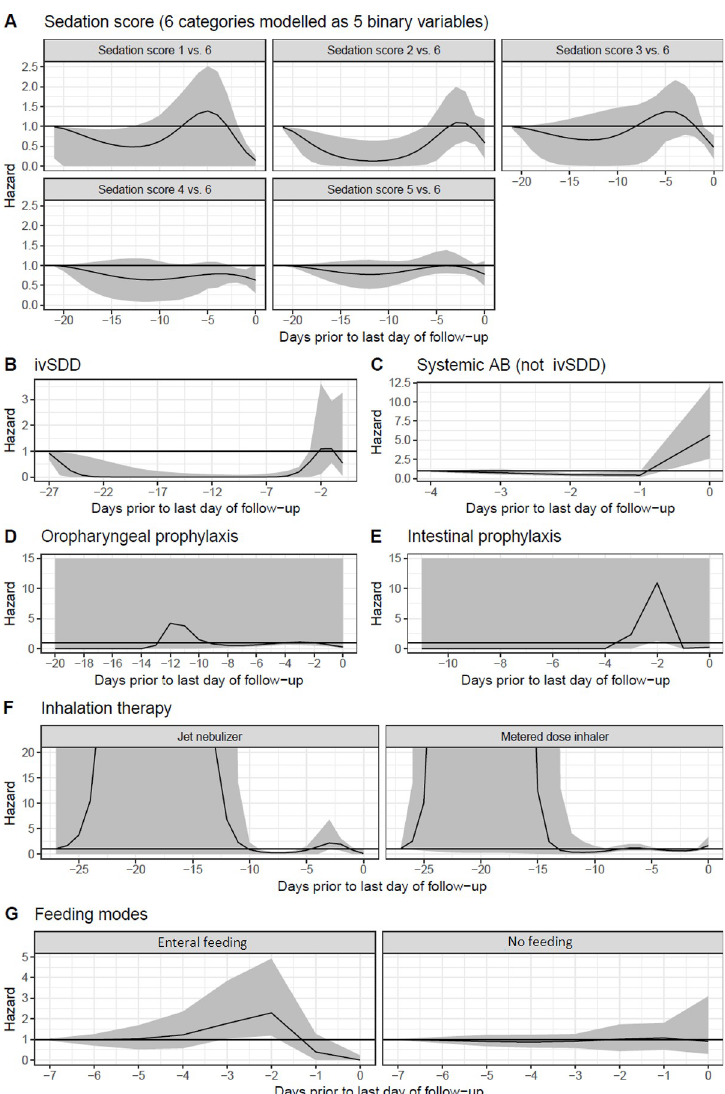
Fig 3. Daily hazards of time-dependent covariates, in univariate models. The curve shows the estimated risk attributed to exposures on each day prior to the last day of follow-up (i.e., the event date or the censoring date) and the grey ribbon shows the 95% confidence interval. A value of one indicates no effect of the exposure at that time. At times where the grey ribbon includes one, the effect is considered to be statistically